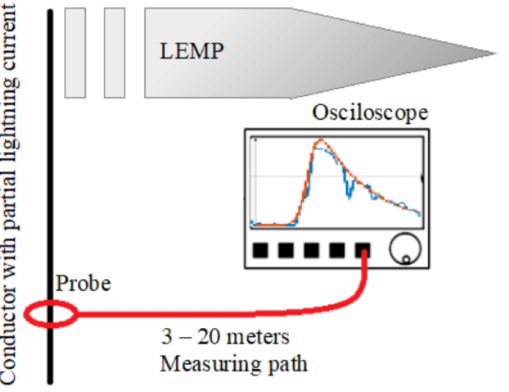
Figure 1. Scheme of propagating the LEMP